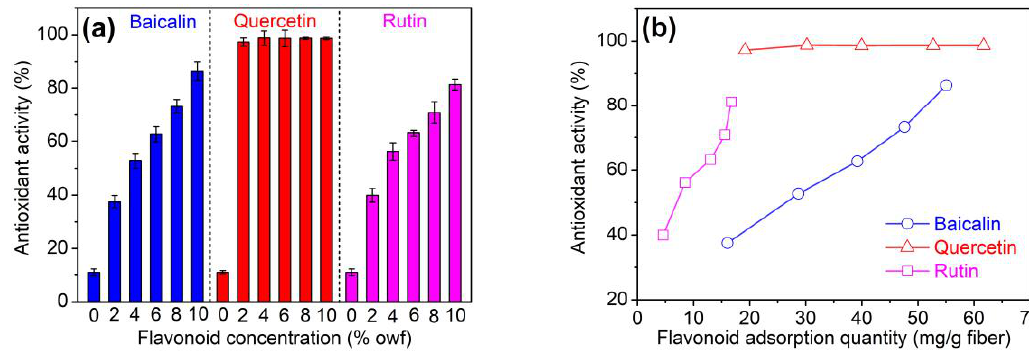
Figure 6. Antioxidant property of polyamide fibers treated using flavonoids at different dosages ( a ) and adsorption quantities ( b ).